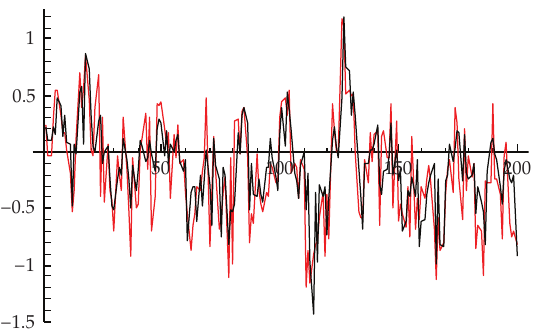
Figure 4: x 2 (cid:5) k (cid:6) and (cid:11) x 2 (cid:5) k/k (cid:6) versus k .